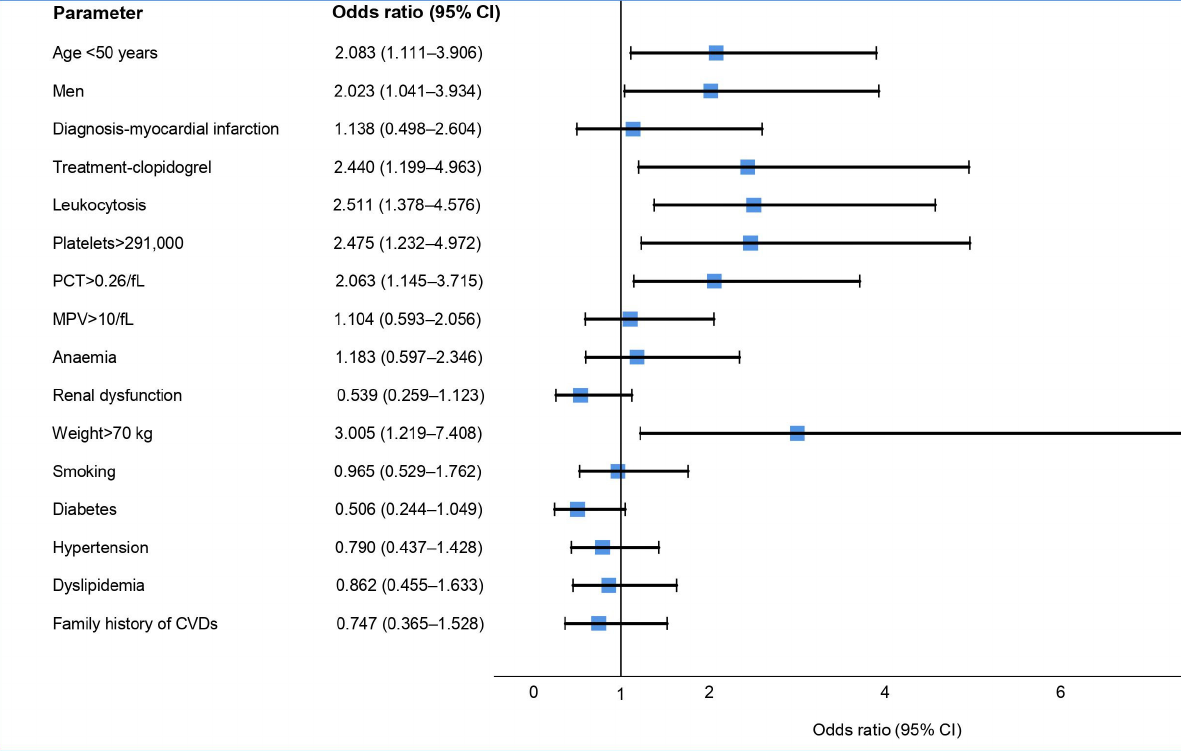
Figure 2. Risk factors for aspirin